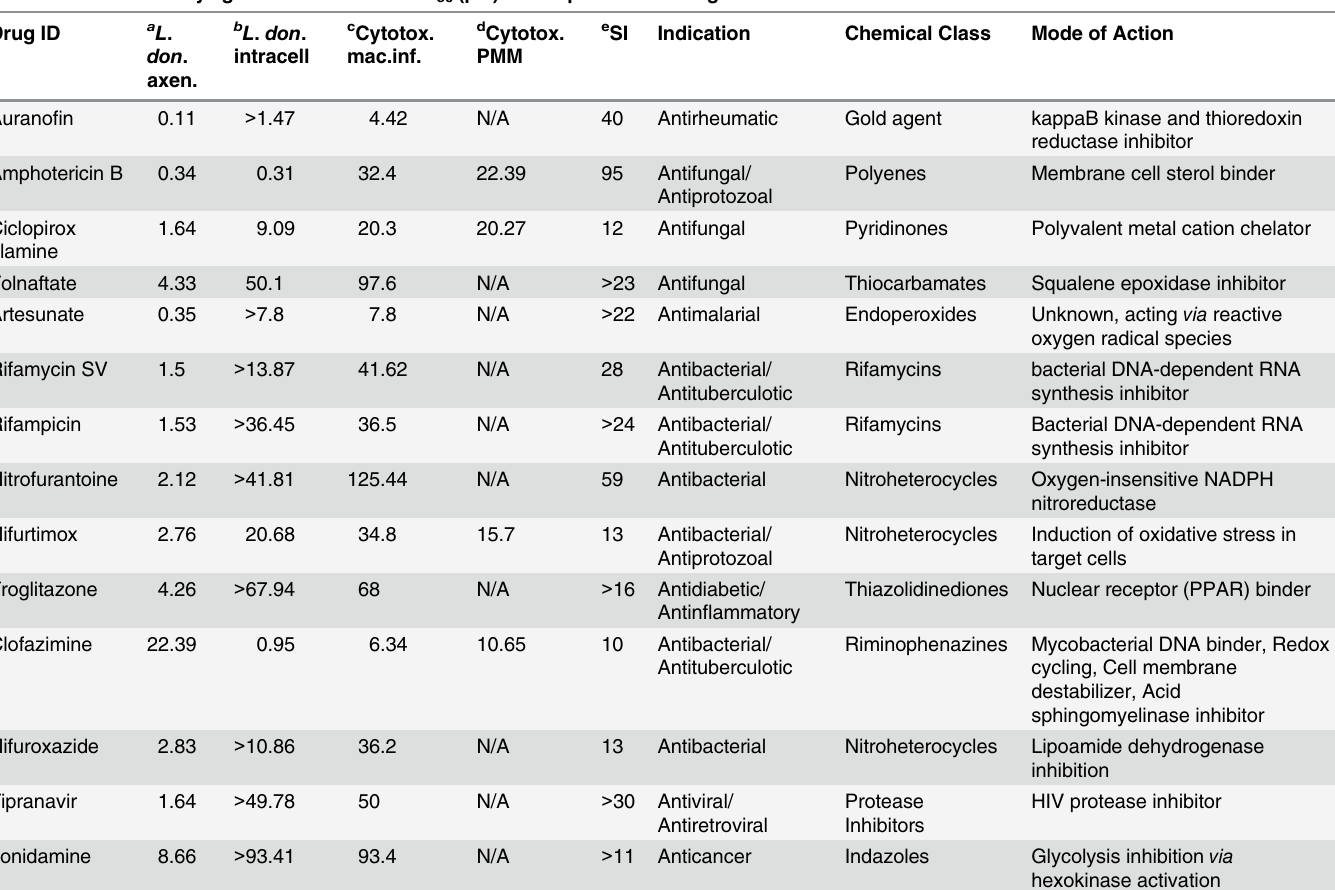
Table 3. In vitro activity against L . donovani in IC 50 ( μ M) of compounds fulfilling hit criteria. Drug ID a L . don .